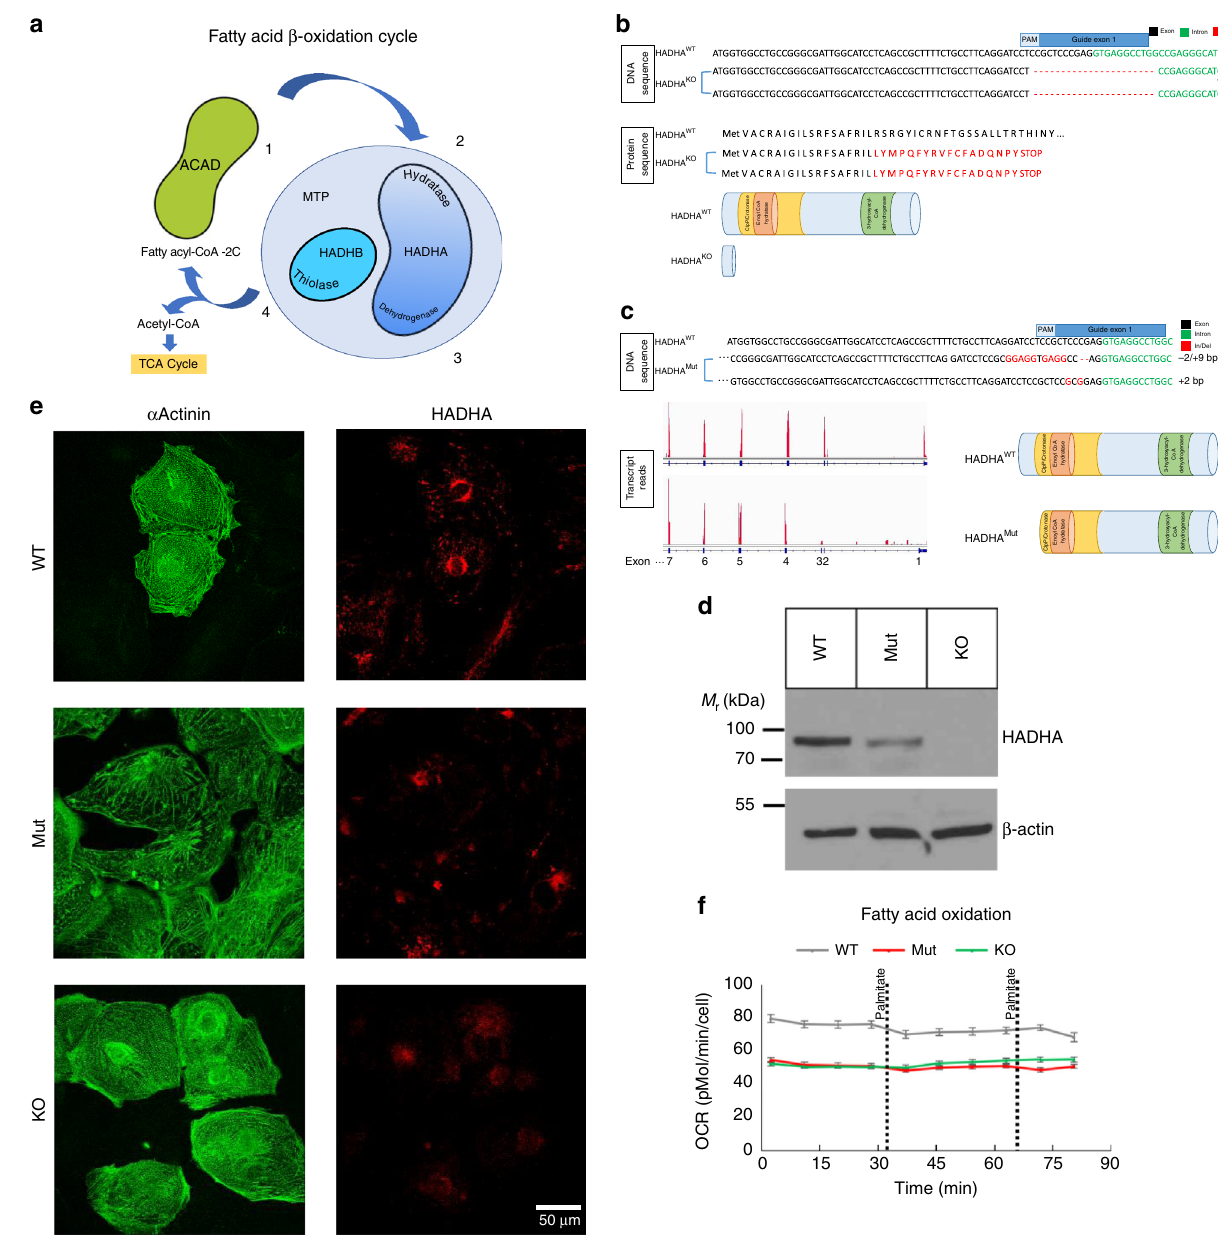
Fig. 1 Generation of HADHA Mutant and Knockout stem cell derived cardiomyocytes. a Schematic of fatty acid beta-oxidation detailing the four enzymatic steps. b Schematic of HADHA KO DNA and protein sequence from WTC iPSC line showing a 22 bp deletion, which resulted in an early stop codon. c Schematic of HADHA Mut DNA and protein sequence from WTC iPSC line showing a 2 bp deletion and 9 bp insertion on the fi rst allele and a 2 bp deletion on the second allele. RNA-Sequencing read counts show that the HADHA Mut expresses exons 4 – 20 resulting in a truncated protein. d Western analysis of HADHA expression and housekeeping protein β -Actin in WTC iPSCs. e Confocal microscopy of WT, HADHA Mut and HADHA KO hiPSC-CMs for the cardiac marker α Actinin (green) and HADHA (red). f Seahorse analysis trace of fatty acid oxidation capacity of WT, HADHA Mut and HADHA KO hiPSC-CMs. n = 6 – 7 biological replicates. Source data are provided as a Source Data fi